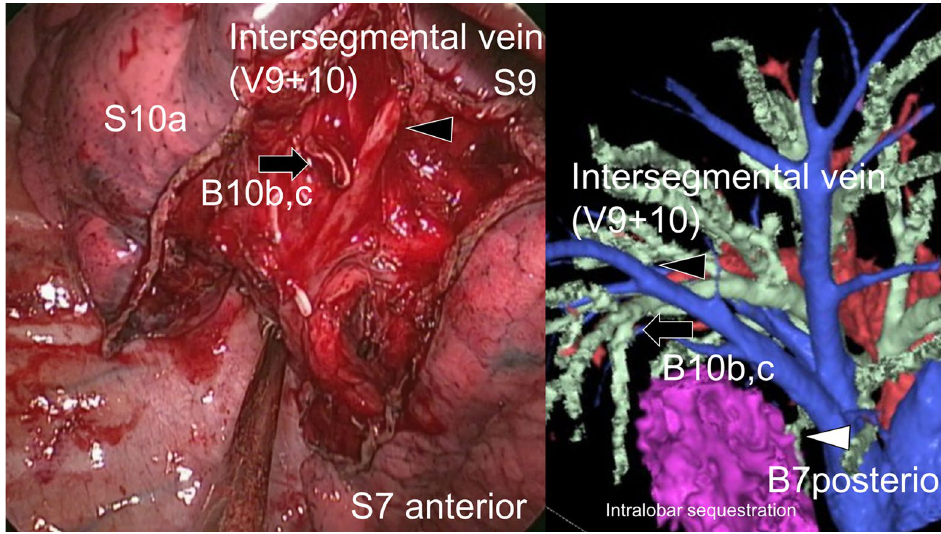
Fig. 3 Thoracoscopic combined basilar subsegmentectomy (S7 posteror